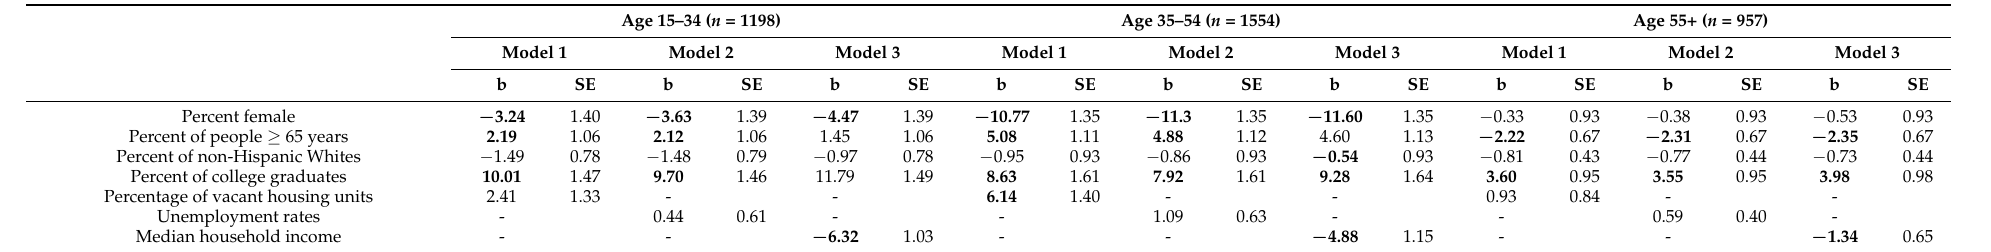
Table 3. Association between county economic changes and changes in county drug mortality rates from 2004–2007 to 2016–2019: Age-specific mortality rates.